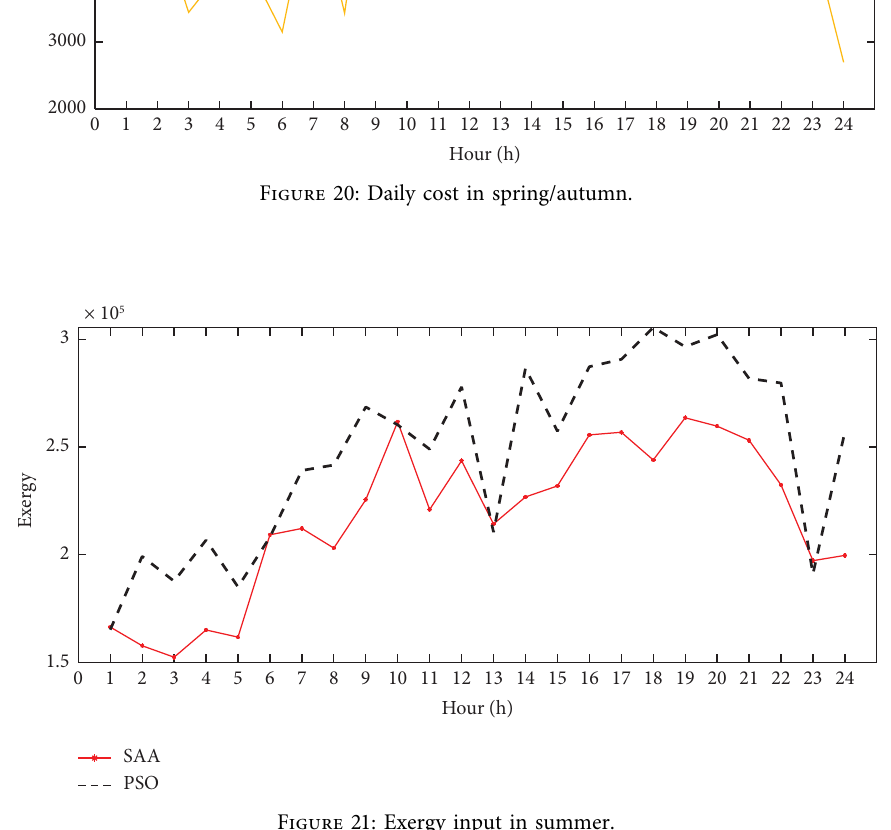
Figure 21: Exergy input in